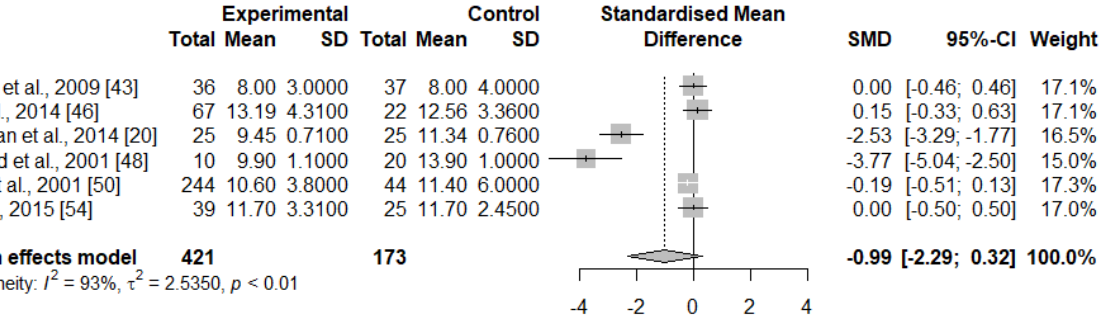
Figure 4. Random-effect meta-analysis for the levels of circulating B cells in IRPL and HC women.